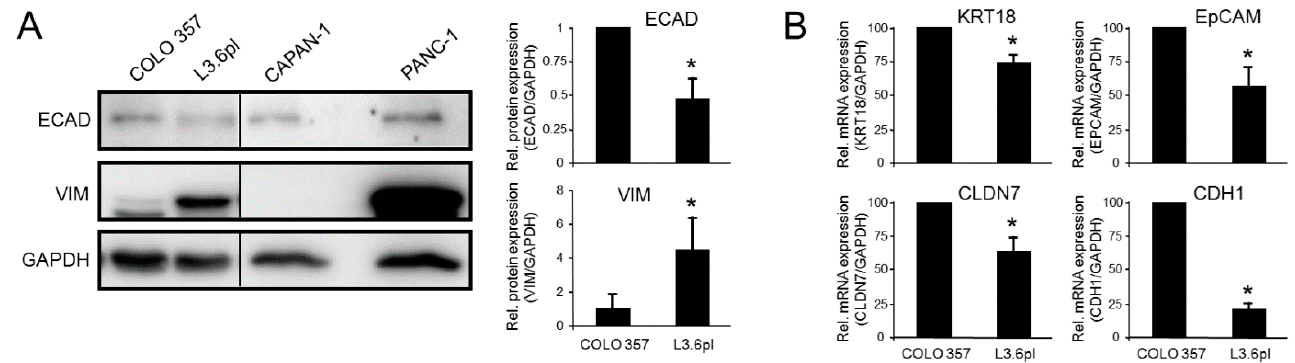
Figure 2. EMT phenotyping of COLO 357 and L3.6pl cells. ( A ) COLO 357 and L3.6pl cells were studied by immunoblotting for ECAD and VIM. GAPDH was used as a loading control. PANC-1 cells served as a positive and CAPAN-1 cells as a negative control for VIM expression. The graphs to the right represent data quantification of VIM and ECAD (mean ± SD of 3–6 samples taken at regular intervals during continuous culture). The asterisks indicate significant differences ( p < 0.05, Wilcoxon test). ( B ) The same two cell lines were subjected to qPCR analysis of KRT18 , CLDN7 , EPCAM and CDH1 . Data represent the mean ± SD of three parallel wells. The assay shown is representative of three assays performed in total. The asterisks (*) denote significance ( p < 0.05, unpaired two-tailed Student’s t test).